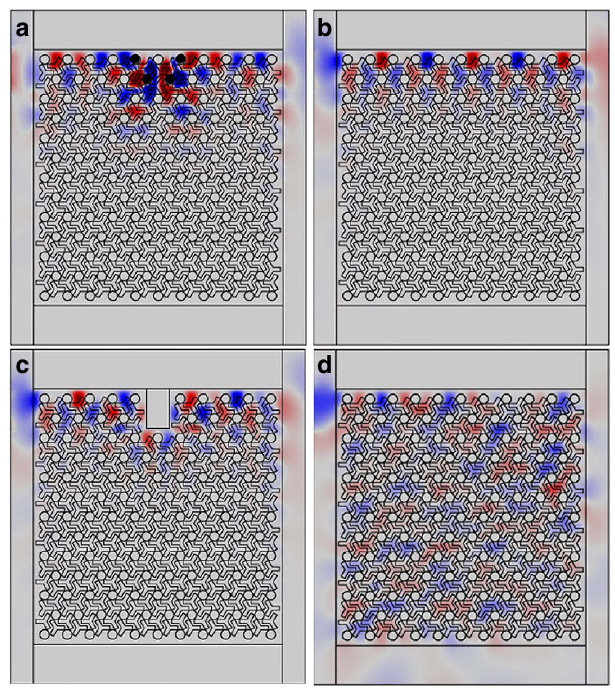
Figure 7 | Robust surface states between the Weyl photonic crystal and the PEC. For a fixed nonzero k z , the surface only supports surface states in one direction. Hence the surface states are robust against scattering that preserves k z . ( a ) Simulated E z field pattern when four PEC rods (shown as black solid circles) near the surface are removed. Electromagnetic (EM) waves with k z ¼ 0.3 p / d and frequency of 12.6GHz hit the photonic crystal from the left. ( b ) Field pattern for the case without defect. ( c ) Field pattern in the presence of a PEC bar. Since both kinds of defects in a and c are periodic in the z direction and k z is conserved, EM waves can pass through or wrap around the defects without backscattering. ( d ) Field pattern when EM waves with frequency of 11.5GHz hit the photonic crystal. Wave with frequency outside the band gap can propagate in the bulk crystal. In a – d , the upper surface of the Weyl photonic crystal is bounded by PEC while the other three surfaces (left, right and bottom) are surrounded by air where EM wave can propagate.